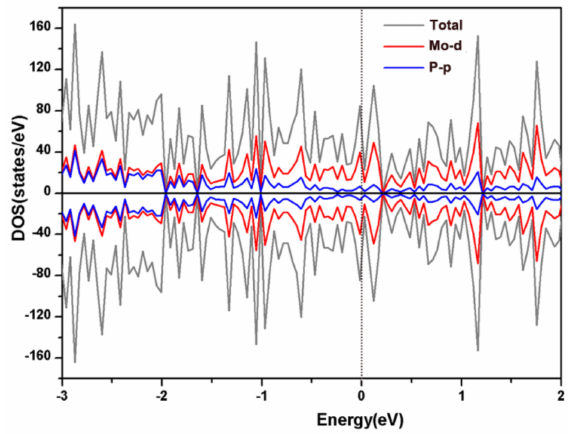
Figure 2. Project and total density of states of the (111)